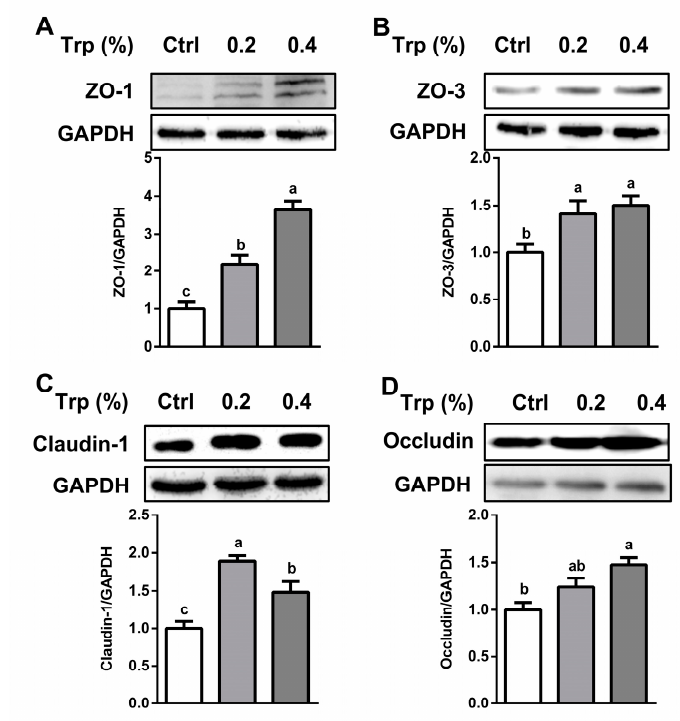
Figure 1. Protein abundances of ZO-1, ZO-3, claudin-1, and occludin in the jejunum of weaned piglets receiving dietary supplementation with 0% (Control, Ctrl), 0.2%, or 0.4% Trp. Western blot analyses of ZO-1 ( A ), ZO-3 ( B ), claudin-1 ( C ), and occludin ( D ) were performed. Values are means ± SEM, n = 6. Means without a common letter differ, p < 0.05.